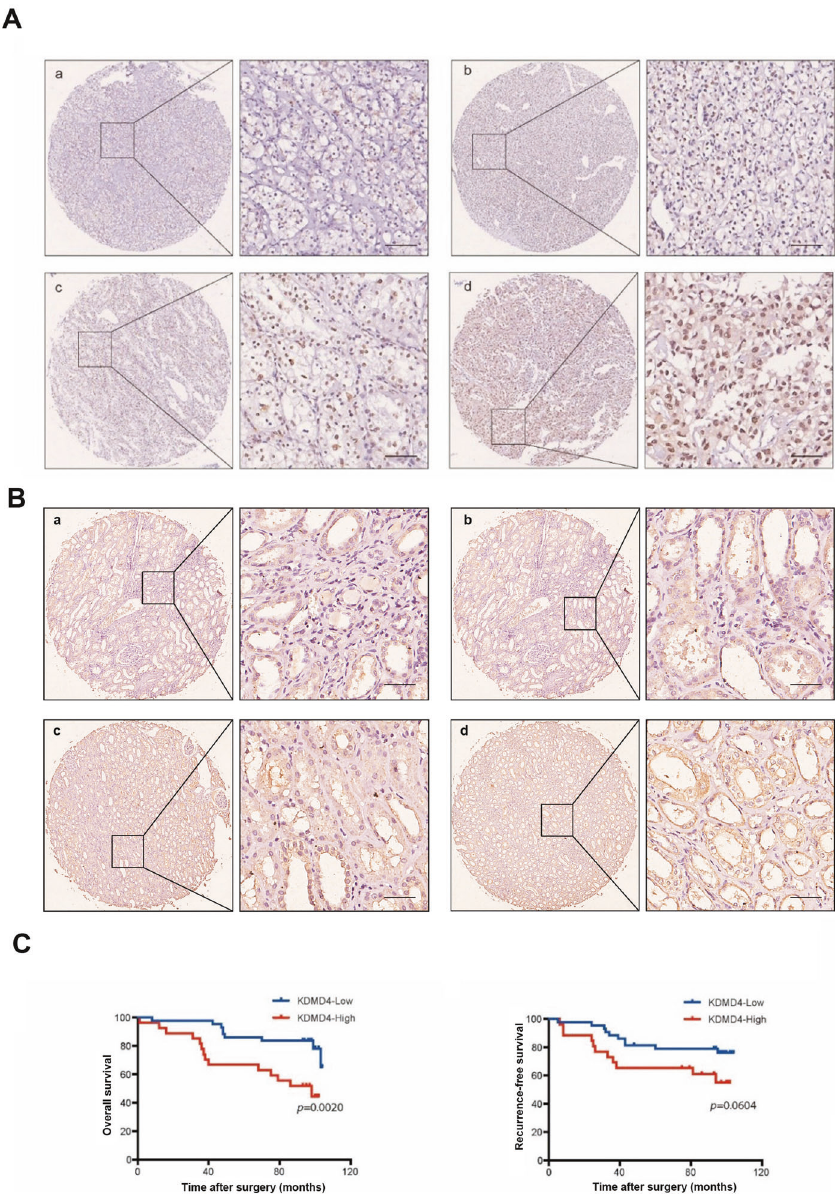
Fig. 1 High expression level of KDM4D portend a worse prognosis and outcome. A Images of IHC staining of KDM4D in tissue microarrays. a minimum expression, b low expression, c moderate expression, d high expression. Scale bar = 100 μ m. B Images of IHC staining of KDM4D in paracancerous tissue. a minimum expression, b low expression, c moderate expression, d high expression. Scale bar = 100 μ m. C Kaplan – Meier curves of overall survival and recurrence-free survival, OS in KDM4D-high group is signi fi cantly lower than KDM4D-low group ( p =